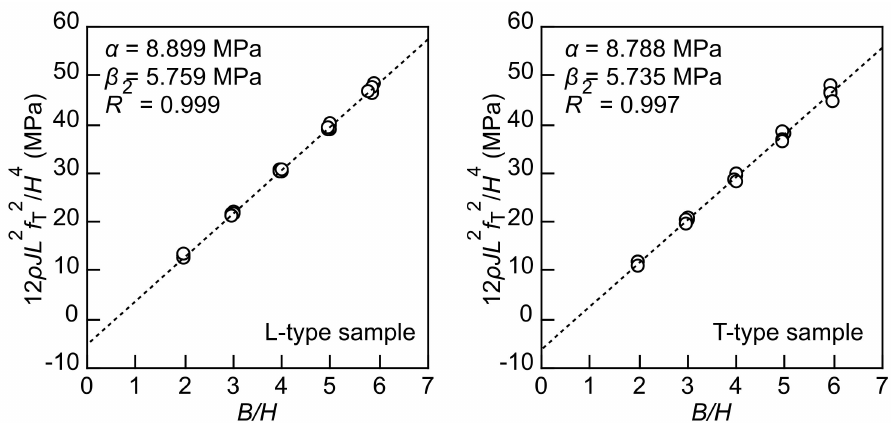
Figure 3. The 12 rJLf T2 / H 4 – B/H relation and a and b values obtained from the linear regression represented by the dashed line.